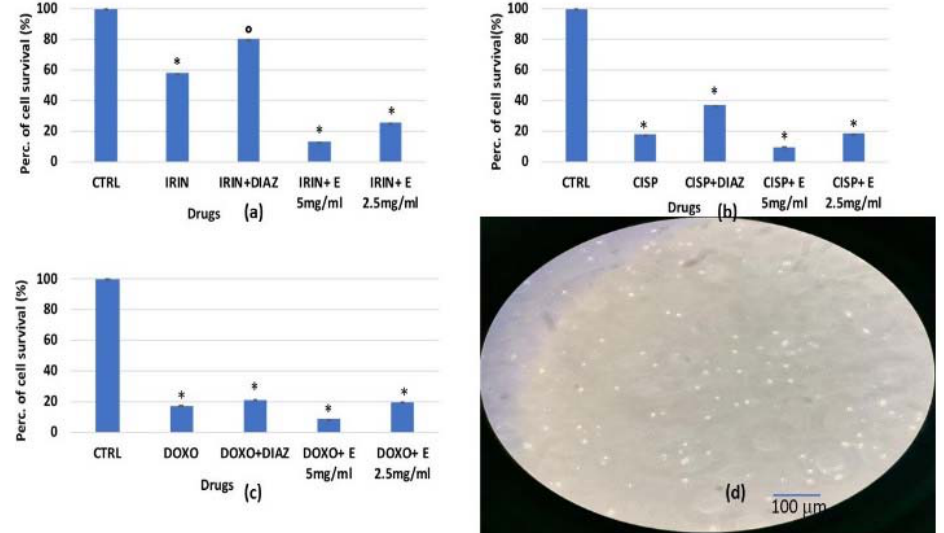
Figure 1. Percentage of the cell growth values of murine bone marrow cells after 96 h of incubation with ( a ) irinotecan 1 × 10 − 4 M (IRIN), ( b ) cisplatin 1 × 10 − 4 M (CISP), ( c ) doxorubicin 2 × 10 − 6 M (DOXO) and diazoxide 2.5 × 10 − 4 M (DIAZ) or different concentrations of the extract (E) measured via crystal violet assay. ( d ) Image of murine bone marrow cell culture at 50% confluency. The reported values represent an average of at least four replicates. One-way analysis of variance with ANOVA was performed to determine the significance of the data vs. controls (CTRL) * or vs. cytotoxic compounds ◦ with a value of p < 0.05.